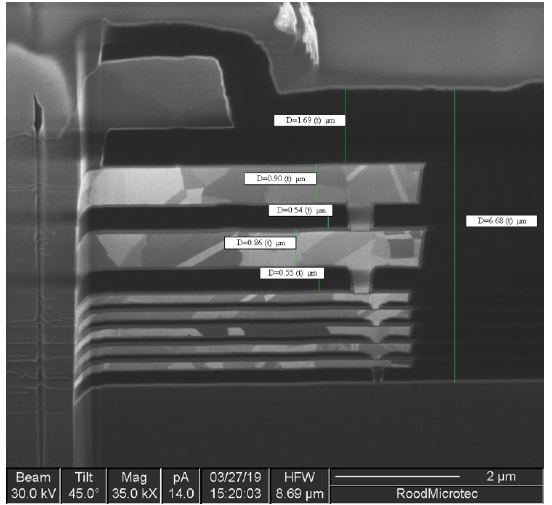
Figure 4. Focused ion beam (FIB) cross section of the die with the measured thickness.